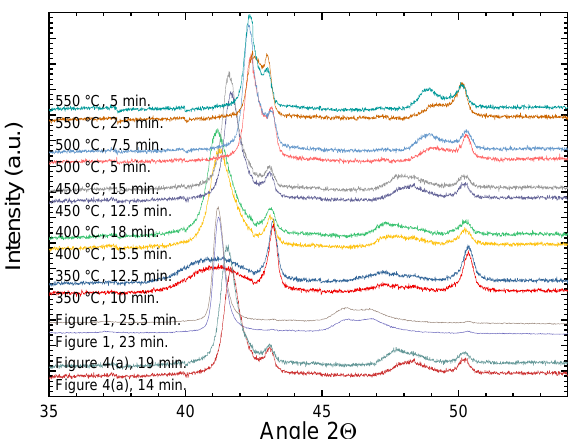
Figure 2. Selected spectra taken during a temperature series for low energy ion nitriding of steel 1.4571 [21] at different temperatures for a fixed ion current density of 130 µA/cm 2 , together with two spectra each from the experimental results depicted in Figure 1 and Figure 4a. The spectra from the experiment depicted in Figure 1 were measured with a newer detector and thus show less noise than the others.